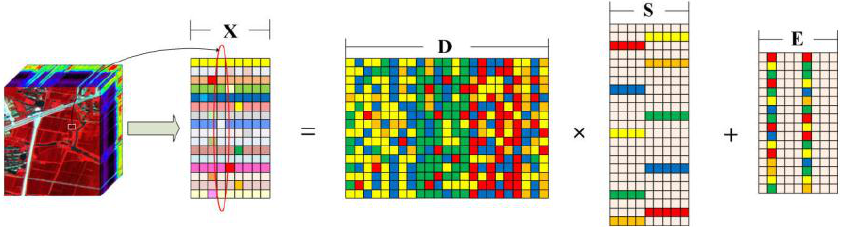
Figure 1. Data model of LRASR.